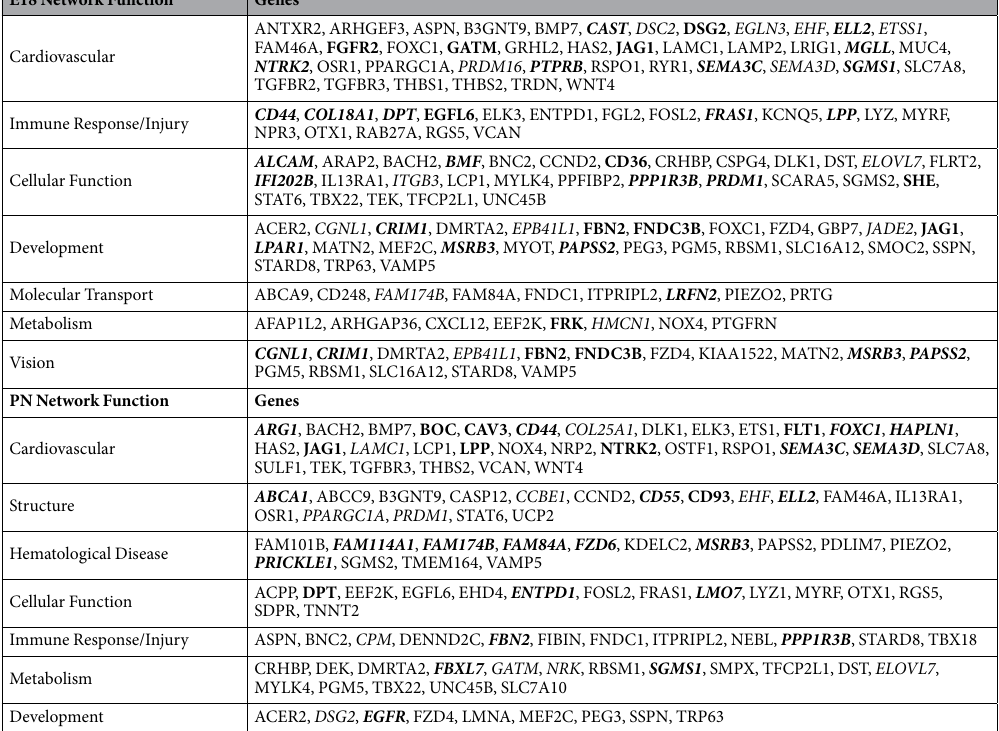
(Supplemental Table S1) which were further analyzed by Ingenuity Pathway Analysis (IPA). IPA analysis revealed eighteen unique gene networks including those for metabolism, development, immune response, cancer, and cellular function (Table 2). These putative miRNA targets are associated with over 50 diseases including diabe- tes, mellitus, cell proliferation of cancer, neuro-inflammation, apoptosis of neuroblastomas, and heart disease (Table 3). Figure 3 summarizes the combined networks and their common targets and pathways.